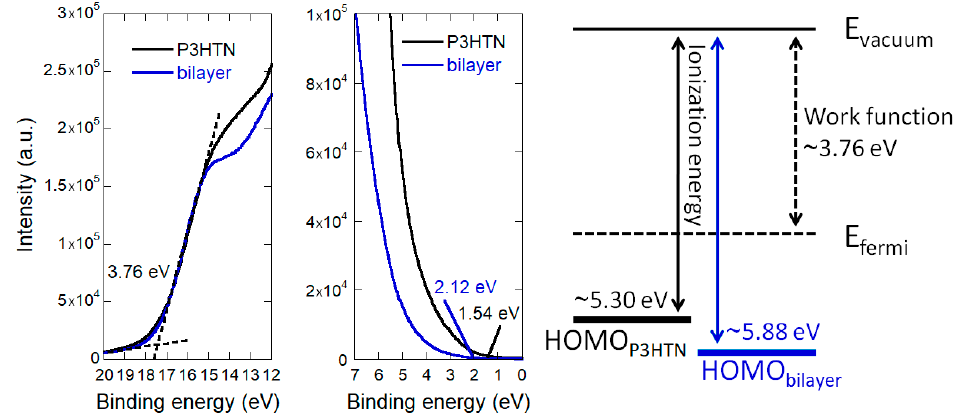
Figure 3. UV photoelectron spectroscopy (UPS) measurements of P3HTN and PEDOT:PSS/P3HTN bilayers deposited on indium tin oxide (ITO) substrates and schematic representation of the deepening of P3HTN highest occupied molecular orbital (HOMO) upon ion exchange with